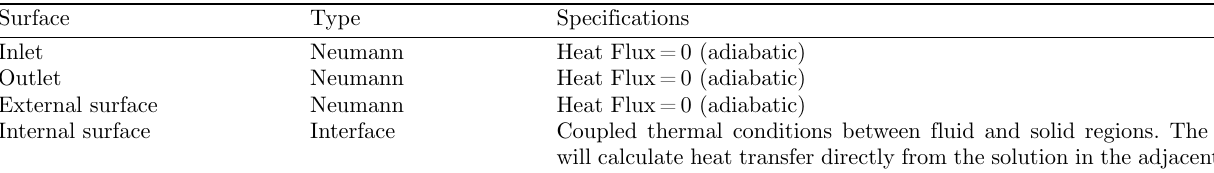
Table 4. Energy boundary conditions used for the solid